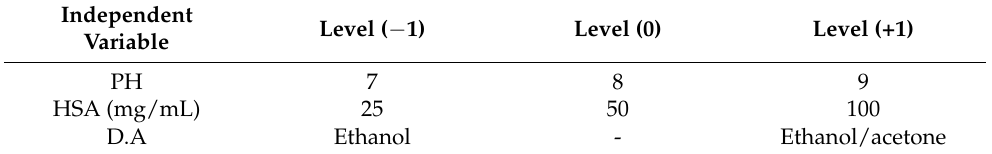
Table 4. Factors controlling SML-ANPs preparation and their levels in D-optimal